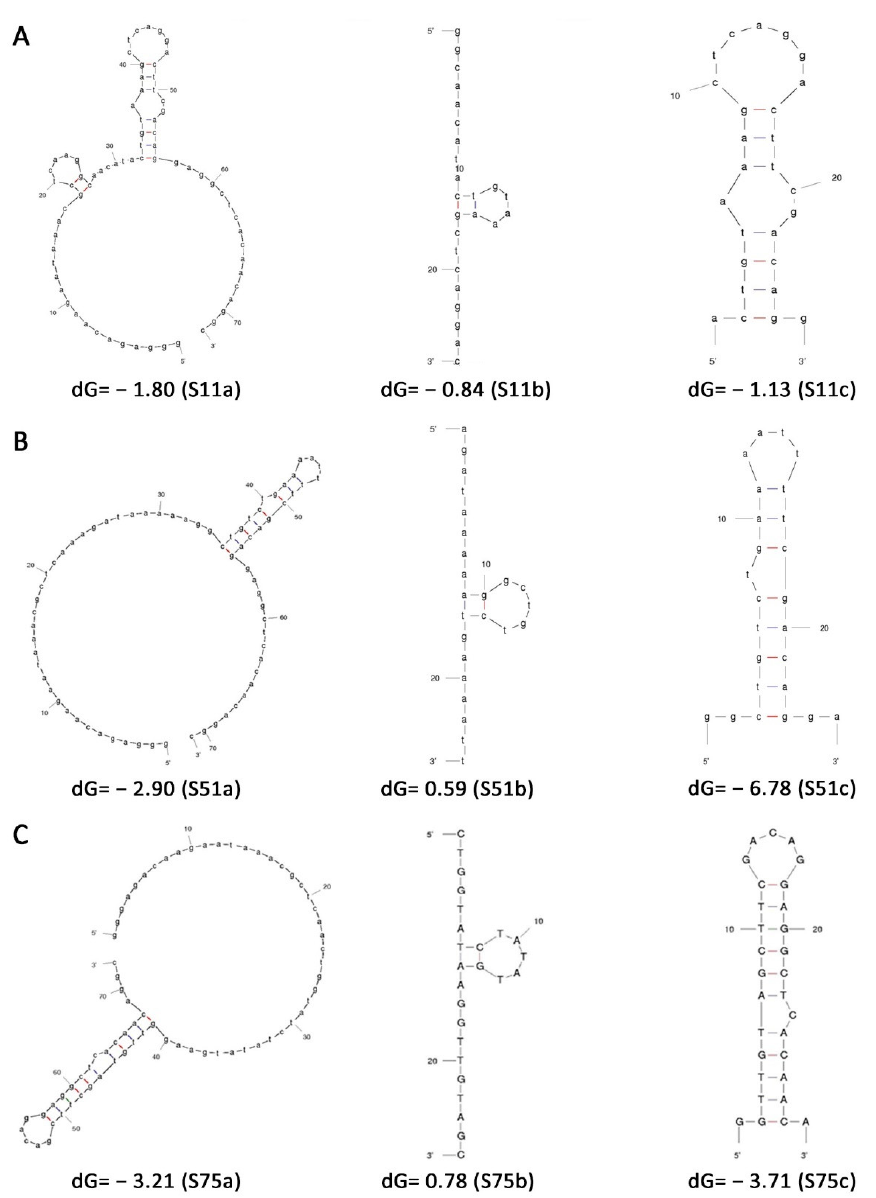
Figure 1. The three selected aptamers, ( A ) S11, ( B ) S51, and ( C ) S75 in three presentations: entire aptamer (left), variable region (middle), and structured region (right). All dG values are expressed in Kcal/mol.